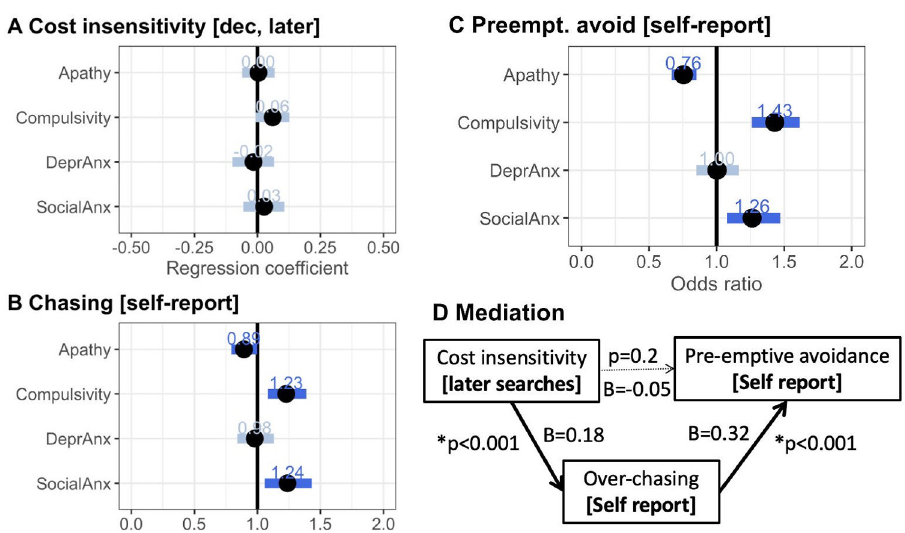
Fig 5. Compulsivity scores, cost insensitivity during sequences of choices, and preemptive avoidance of biases (confirmation sample). During later searches, higher compulsivity scores related to insensitivity to costs (A) . Compulsivity was further related to increased self-reported chasing (B) . (C) Increased compulsivity scores were, however, also related to increased self-reported preemptive avoidance of trials, which participants perceived as likely to lead to oversearching. (D) A mediation analysis revealed that the cost insensitivity bias during a sequence of choices was related (full mediation) to self-reported preemptive avoidance via self-reported awareness of a tendency to overchase. Stats in A–C are 95% Bayesian credible intervals (1 tailed); significance is shown by credible intervals not including zero and dark blue colour. D reports results of frequentist t tests at p < 0.05. Data in this figure are available in S2, S9, and S16